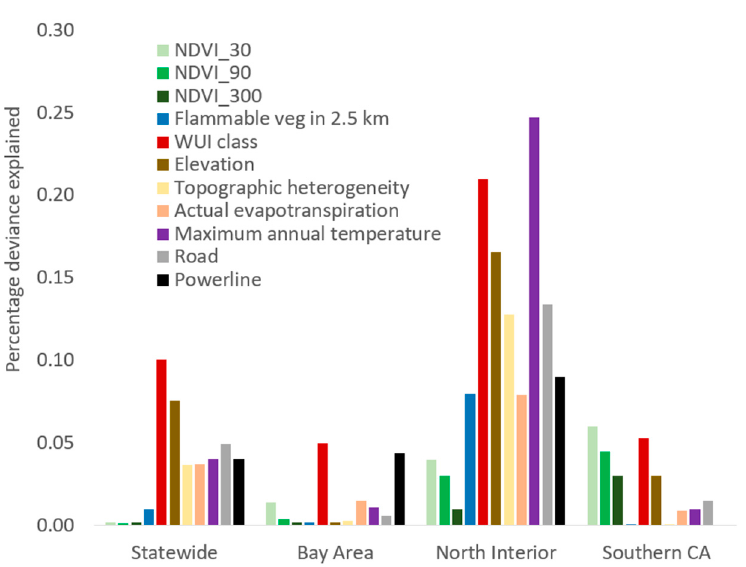
Figure 3. Percentage deviance explained for unburned versus destroyed structures in binomial regression models statewide and for three regions in California. The numbers following “NDVI” represent the buffer distance surrounding structures for which the Normalized Difference Vegetation Index (NDVI) was calculated.